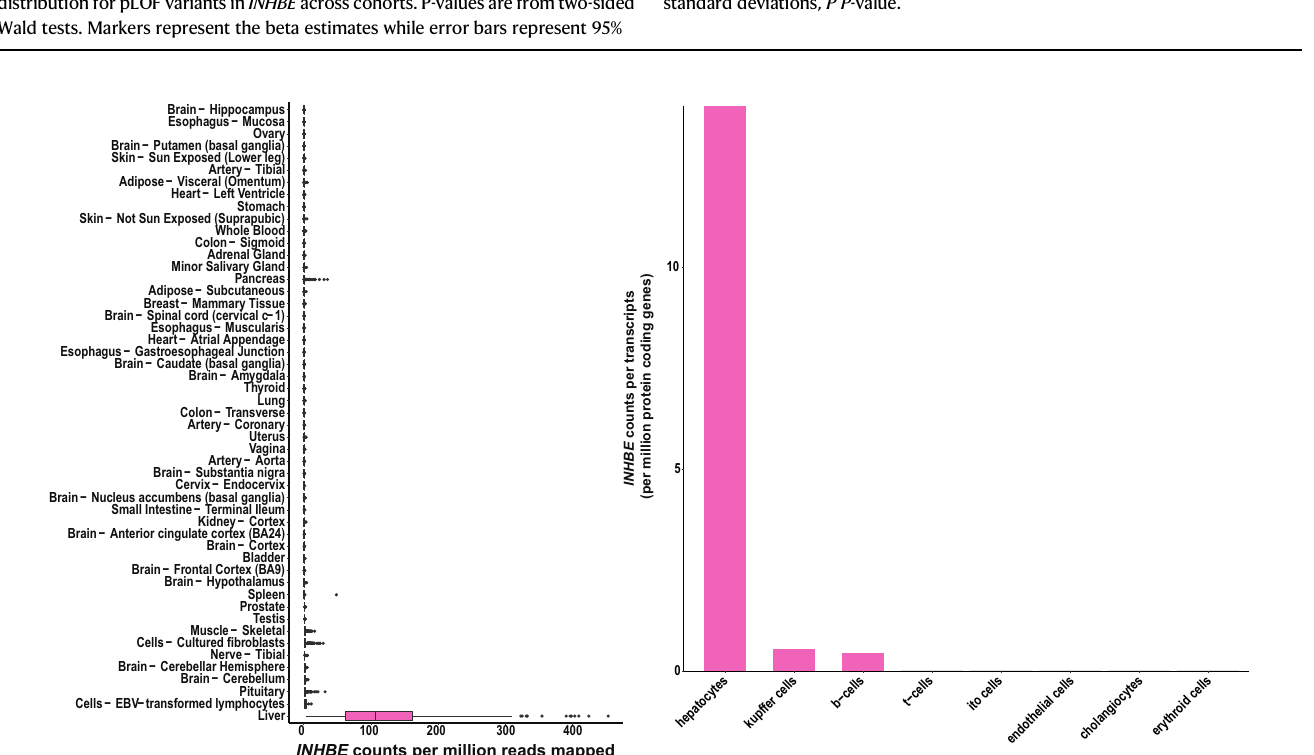
con fi dence intervals. The gray diamond represents meta-analysis estimates. BMI body mass index, WHR waist-hip ratio, pLOF predicted loss of function, AAF alternativeallelefrequency,UKBUKBiobank,MDCSMalmöDietandCancerStudy, MCPS Mexico City Prospective Study, AFR African ancestry, SAS south-Asian ancestry, EUR European ancestry, AMR admixed-American ancestry, RR reference- reference homozygous genotype, RA reference-alternative heterozygous geno- type, AA alternative-alternative homozygous genotype, CI con fi dence interval, SD standard deviations, P P -value.